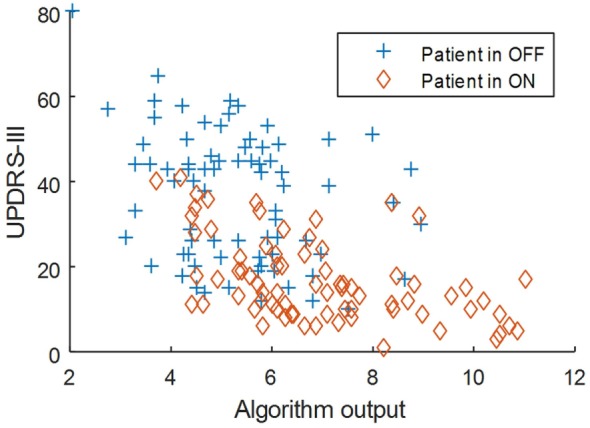
Scatter plot of the algorithm output against UPDRS-III total score.